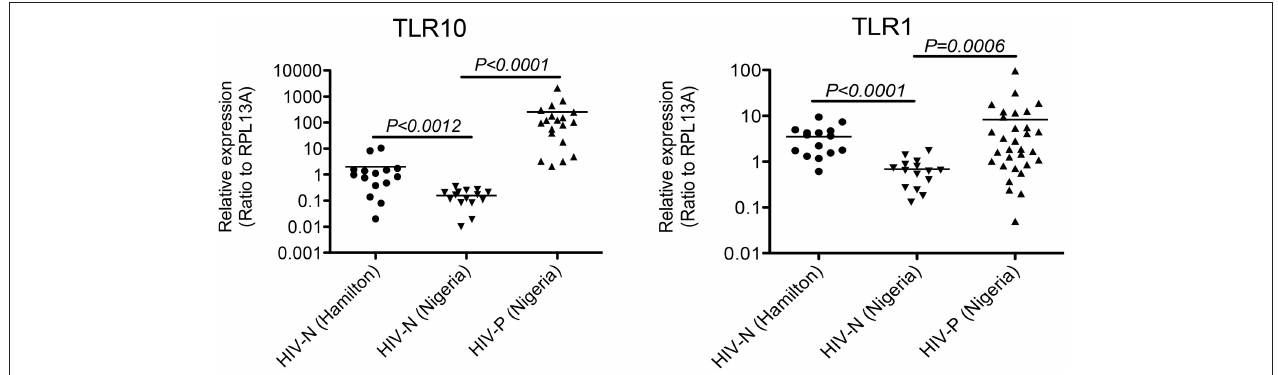
FIGURE 2 | Significantly elevated expression level of TLR1 and TLR10 in HIV-1 infected human primary BM cells. Expression of TLR1 and TLR10 as measured by qRT-PCR with the mRNA extracted from primary BM cells collected from HIV-1 negative Hamilton, Canada women (HIV-N Hamilton) and Nigerian HIV-1 negative (HIV-N) and HIV-1 positive (HIV-P) women. TLR1 expression is shown on right ( p = 0.0006) whereas TLR10 expression is shown on left ( p < 0.0001).